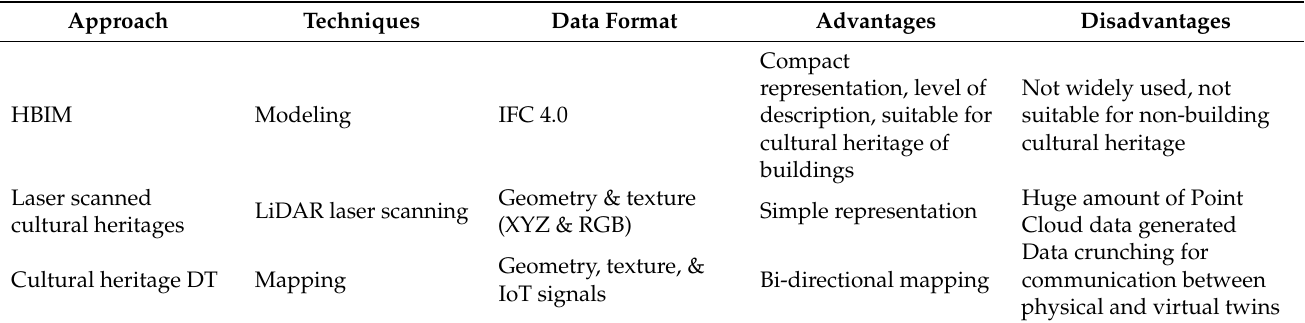
Table 1. Comparison of different methods for heritage